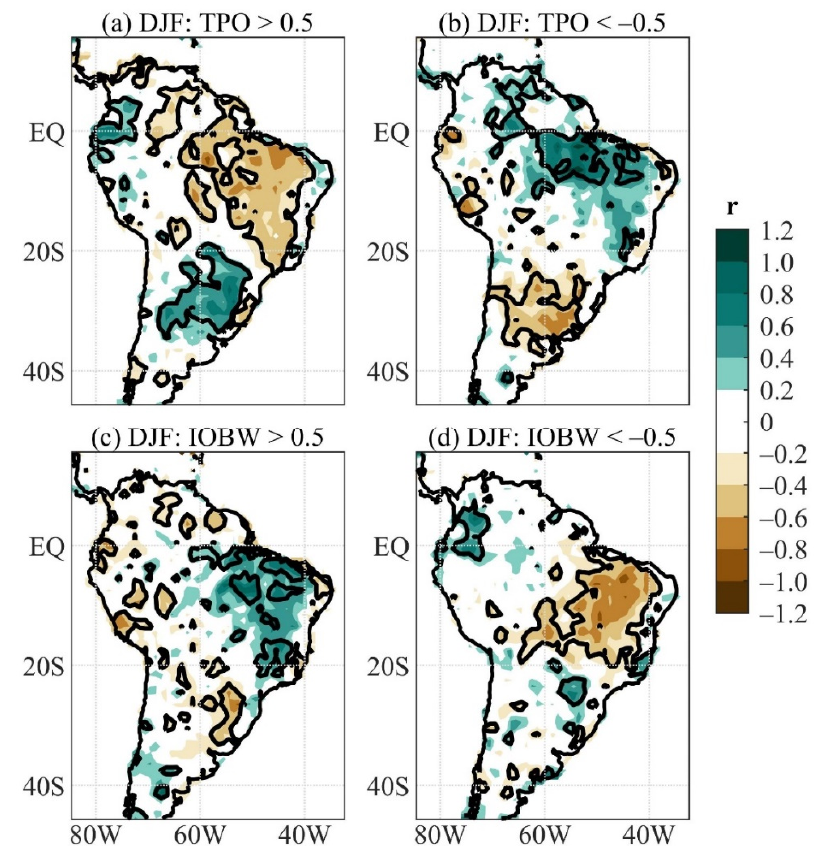
Figure 10. Composite analyses of residual precipitation anomalies for ( a ) TPO > 0.5; ( b ) TPO < –0.5; ( c ) IOBW > 0.5; ( d ) IOBW < –0.5. Continuous line encompasses the significant values at a 95% confidence level using Student’s t ‐ test.